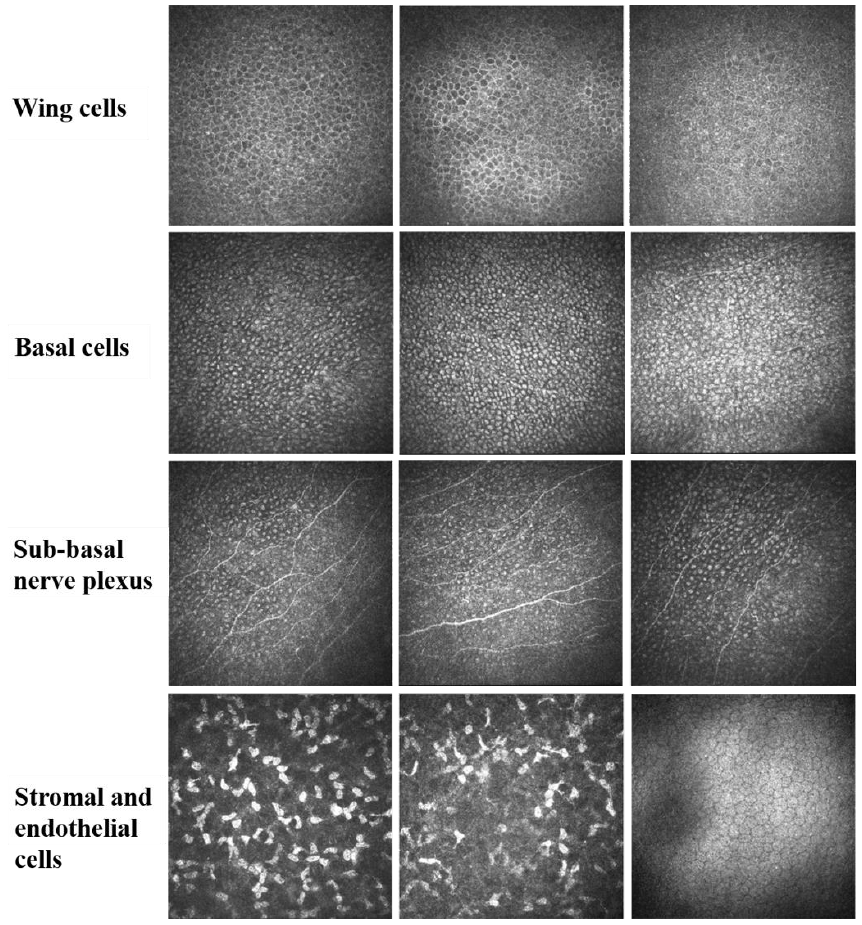
Figure 2. In vivo confocal microscope shows that epithelial cells are edematous with high reflectivity inside the basal cells, but low reflectivity at the cell boundary. This change shows a special stereoscopic appearance, presenting a “relief-like” manifestation. The density of sub-basal nerve plexus displays no significant decrease. Inflammatory cells and activated Langerhans cells are rarely seen. Anterior stromal keratocytes are activated or normal. There is no significant abnormality in the endothelial cells.